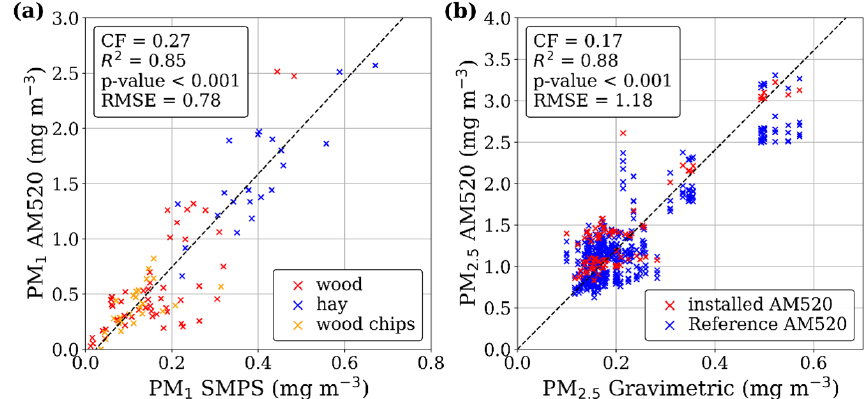
Figure 4. PM 1 concentrations from the AM520 averaged over 160s plotted against the SMPS-derived PM 1 measurements for 14 fires in different fuel types (a) . Fire-averaged PM 2 . 5 concentrations from five different AM520 modules during 10 experiments burning peat and straw, plotted against the gravimetric measurement from the Tapered Element Oscillating Microbalance (b) . The dashed line represents the linear regression line. The VU AM520, shown in red in panel (b) , is used for the other analysis in this study.